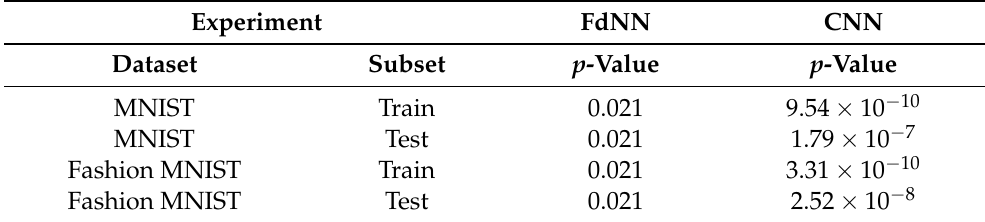
Table 6. Kruskal–Wallis Rank Sum Test between the accuracy in NNs with less than 4096 synapses and with a number of synapses between 4096 and 8192.